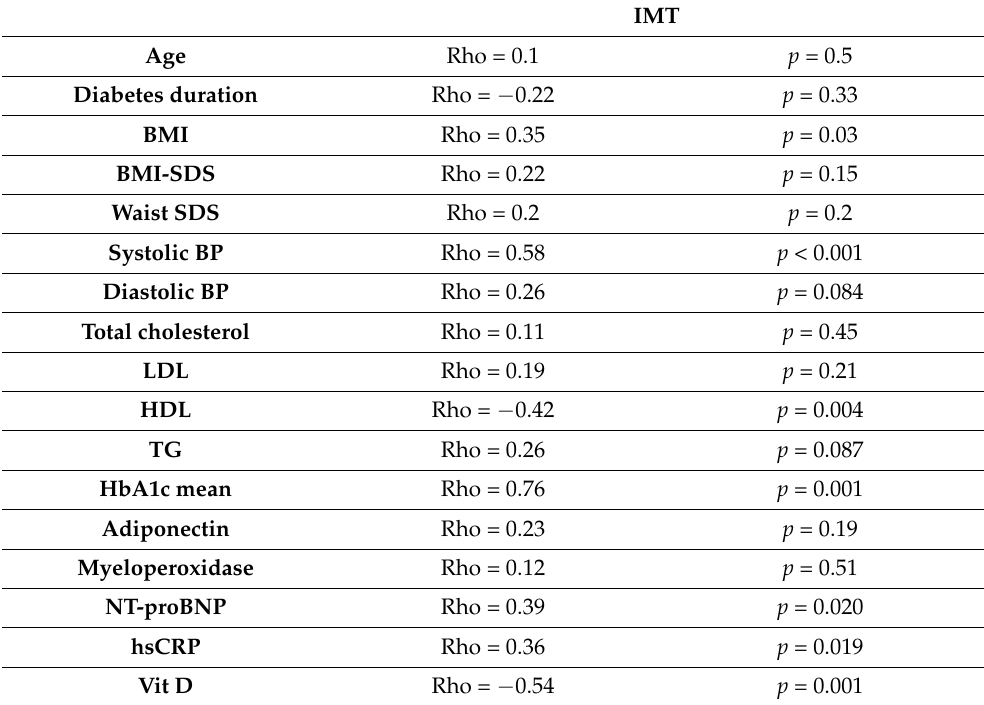
Figure 4. IMT correlations with chosen variables ( A – D ) in patients with T1D and vascular complications. Table 3. Analysis of associations between IMT and studied variables in group of T1D with vascular complications VC